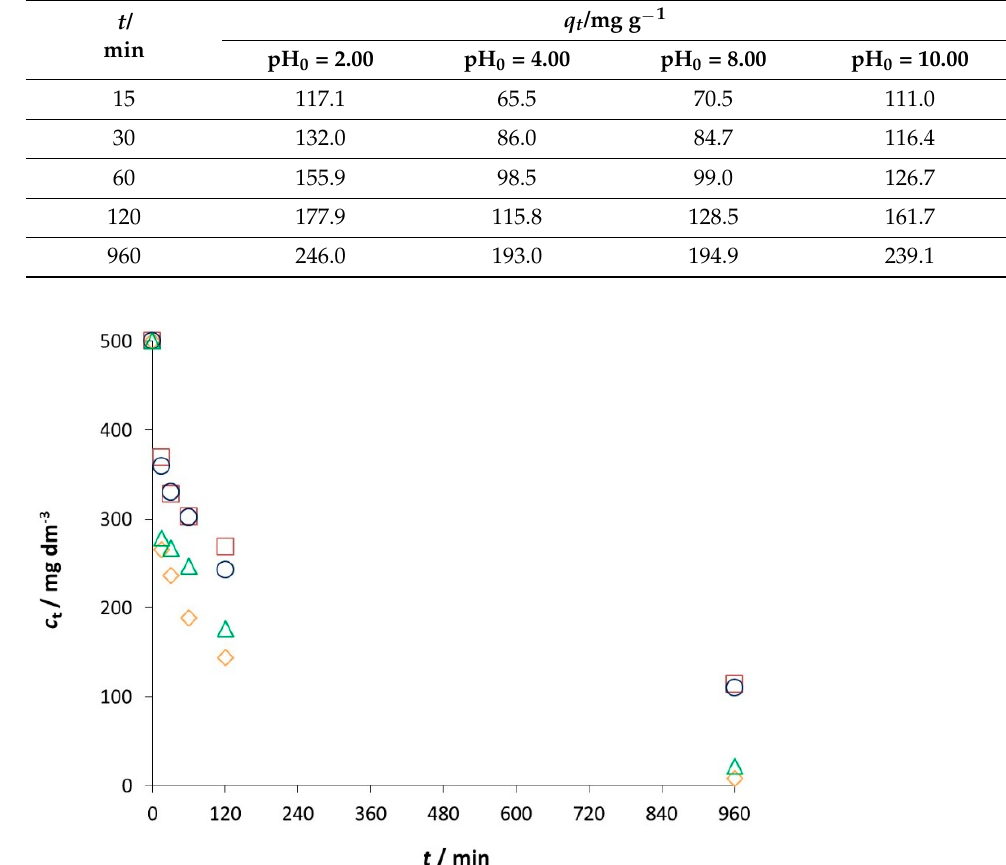
Table 1. Amount of adsorbed Reactive Black 5 (RB5) dye ( q t ) at time t for different initial pH values.